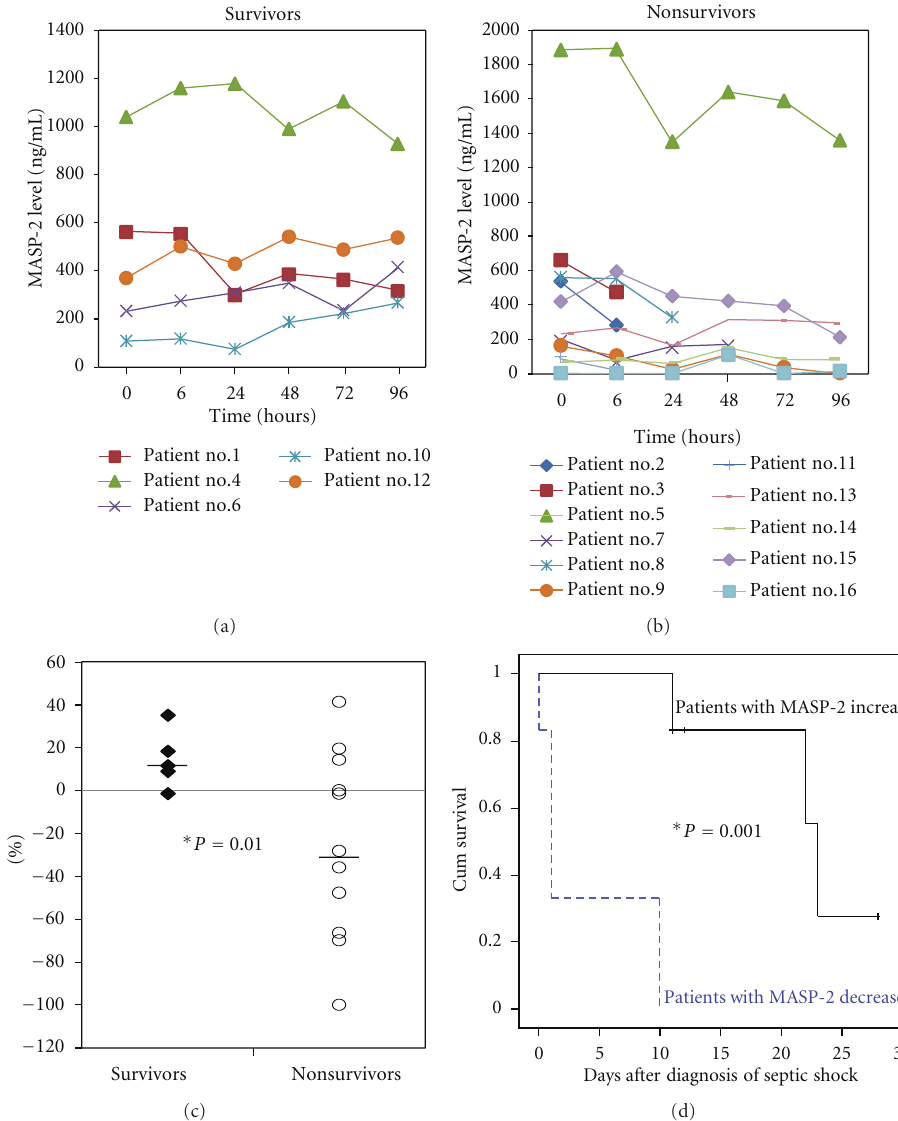
Figure 1: MASP-2 level changes in the survivors or nonsurvivors of septic shock. Plasma levels of MASP-2 were measured over the first 5 days in 16 patients after the diagnosis of septic shock. (a) MASP-2 profiles in the survivors: each line represents an individual patient; (b) MASP-2 profiles in the nonsurvivors; (c) comparison of the change of MASP-2 in survivors versus nonsurvivors at 6 hours after enrollment; (d) the association of changes in plasma levels of MASP-2 at 6hrs after enrollment with hospital outcome. Kaplan-Meier survival analysis was performed to determine if patients with ≥ 10% increase of MASP-2 within 6 hours after the diagnosis of septic shock (solid line) had di ff erent in-hospital mortality rate compared with patients with ≥ 10% decrease of MASP-2 over the same time point (dashed line). ∗ indicates statistical di ff erence ( P <